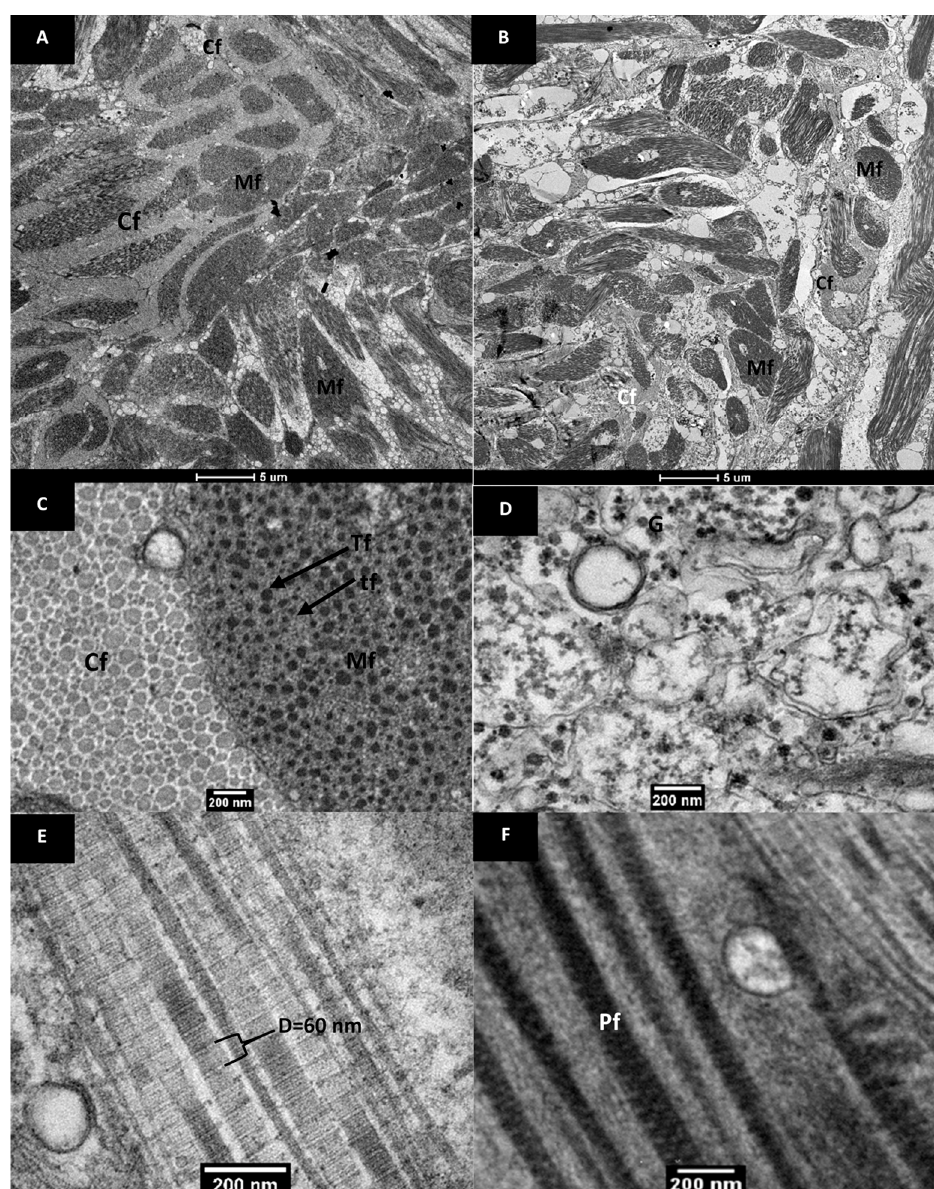
Figure 4. Transmission electron micrographs of raw p¯aua muscle tissue. Cross-sectional views of the ( A ) foot, and ( B ) adductor muscle part. ( C – F ) are from the foot muscle part. ( C ) shows a cross-sectional view of the collagen fibrils (CF) and the myofibrils (Mf) comprising the thick (Tf) and thin (tf) filaments, while ( D ) shows extracellular spaces with glycogen granules. ( E ) shows a longitudinal view of the collagen fibrils showing a banded structure and ( F ) is a longitudinal view of patterned thick filaments identified as paramyosin fibrils (Pf).